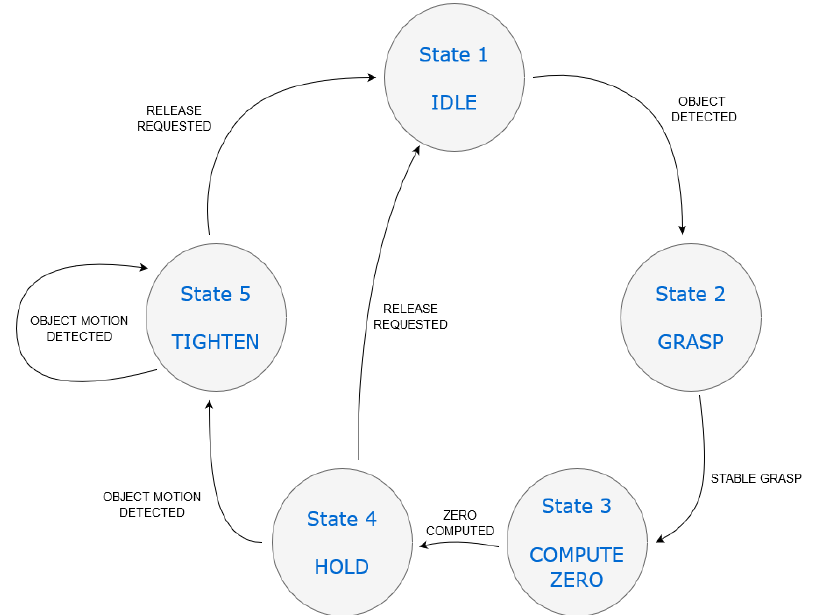
Figure 5. Representation of the state